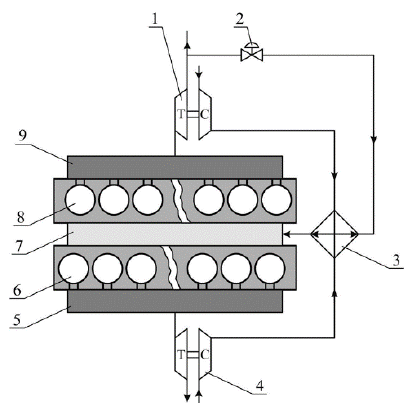
Figure 6. Scheme of the gas-air system of the 16V32 STX-MAN diesel engine: 1, 4 — turbocharger (T — turbine, C — compressor); 2 — valve of the recirculation system; 3 — charge air cooler; 5, 9 —